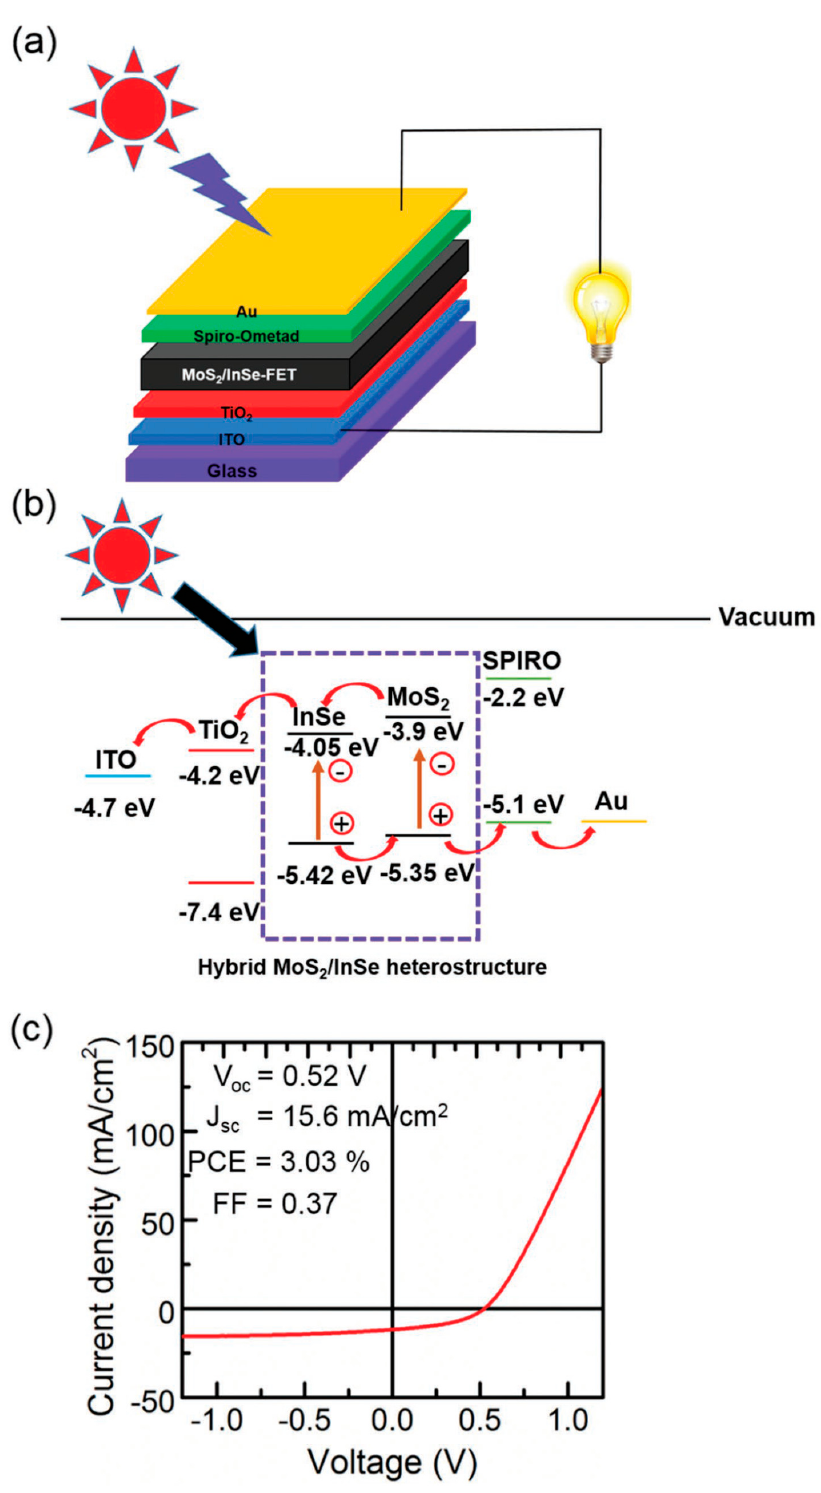
Figure 17. ( a ) Schematic and ( b ) band structure of the solar cells using InSe nanosheets decorated with MoS 2 QDs and ( c ) the current-voltage characteristic. Reproduced with permission from [94]. Copyright WILEY-VCH Verlag GmbH & Co. KGaA, Weinheim, 2019.